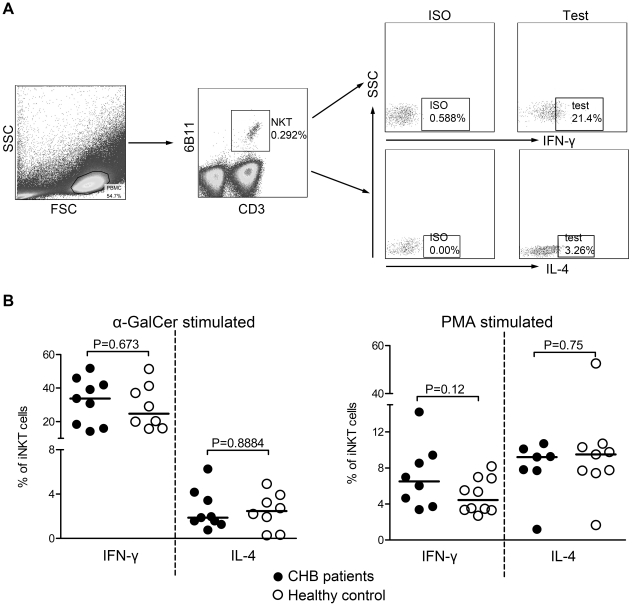
Cytokine secretion of iNKT cells in CHB patients and healthy controls.Fresh isolated PBMC were stimulated with phorbol 12-myristate 13-acetate (PMA) or α-galactosyl ceramide (α-GalCer), a CD1d-restricted antigen recognized specifically by iNKT cells, and the intracellular cytokine were analyzed by flow cytometry. (A) The gating strategy of CD3+6B11+ iNKT cells and representative dot plots of interferon-gamma (IFN-γ) and interleukin-4 (IL-4) expression in iNKT cells from testing samples and isotype controls. (B) Pooled data showed the percentages of iNKT cells producing IFN-γ and IL-4 in response to α-GalCer (left) or PMA (right) in CHB patients and healthy controls. Comparisons between two groups were performed using Mann- Whitney U test.